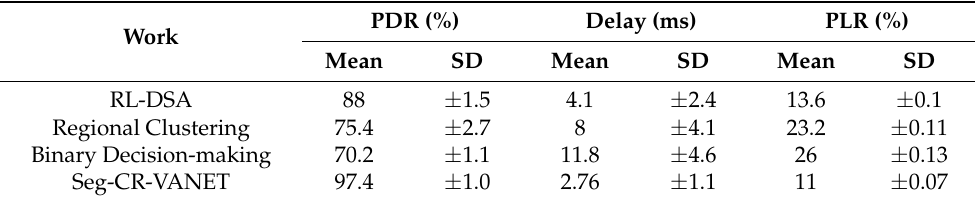
Table 6. Numerical comparison of obtained